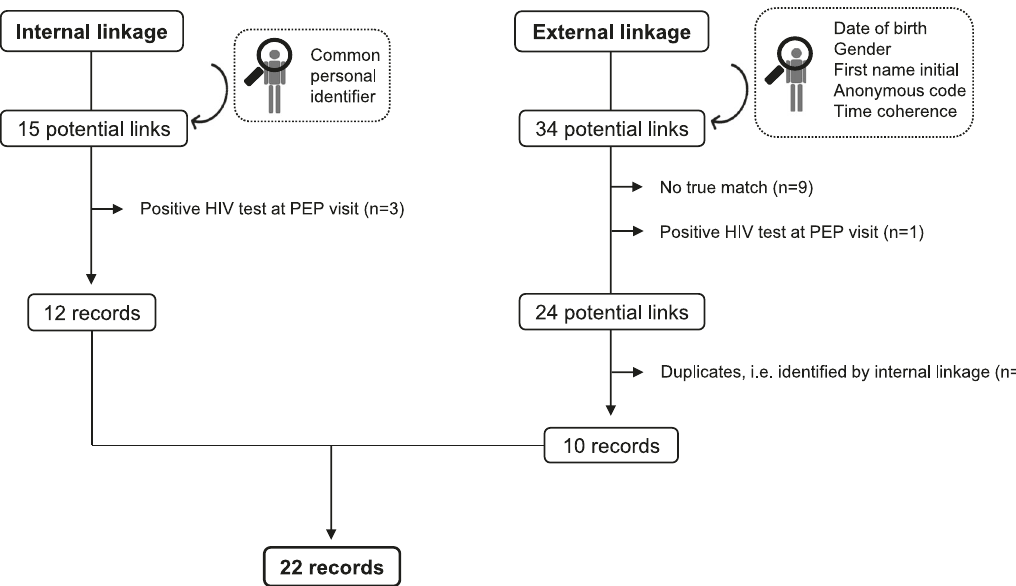
Fig. 1 Flow diagram illustrating the data linkage process. Of 975 records included in the PEP-USZ database, internal linkage yielded 12 records. Ten additional records were retrieved through external linkage. Thus, data linkage resulted in the identi fi cation of 22 HIV infections among individuals seeking PEP between 2007 and 2013. PEP: post-exposure prophylaxis; USZ: university hospital of